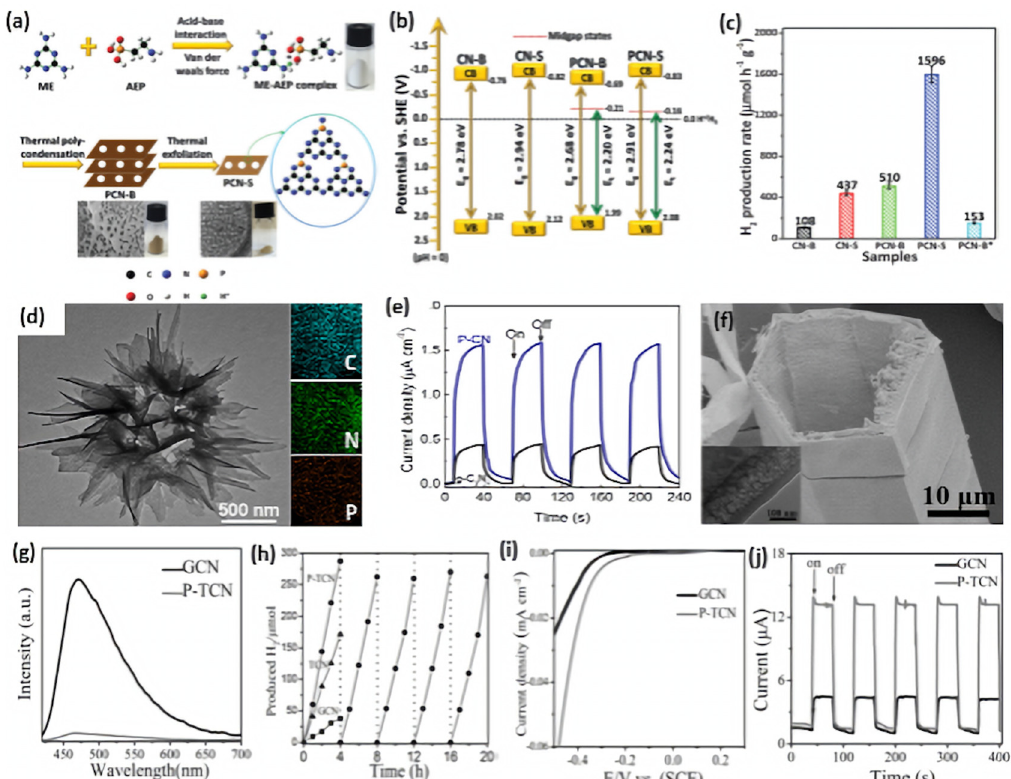
Figure 5. ( a ) Schematic illustration of the synthesis process of porous PCN-S. ( b ) Electronic band structures of CN-B, CN-S, PCN-B, and PCN-S. ( c ) The photocatalytic activity comparison of CN-B, CN-S, PCN-B, PCN-S, PCN-B*; adapted with permission from Ref. [89]. 2015, Royal Society of Chemistry. ( d ) Transmission electron microscope (TEM) image and EDS mapping of P-CN nanoflowers, beside its photocurrent–time curves relative to bulk g-C 3 N 4 flakes ( e ); adapted with permission from Ref. [76]. 2015, American Chemical Society. ( f ) SEM and TEM images of P-TCN. ( g ) PL spectra of GCN and P-TCN. ( h ) Time course of H 2 production for GCN, TCN, and P-TCN. ( i ) Polarization curves of GCN and P-TCN. ( j ) Photocurrent–time curves for GCN and P-TCN; adapted with permission from Ref. [91]. 2016, John Wiley & Sons,